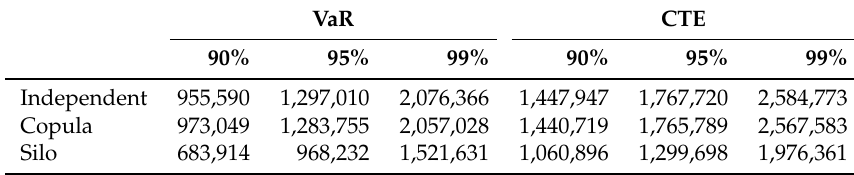
Table 9. Risk reduction from